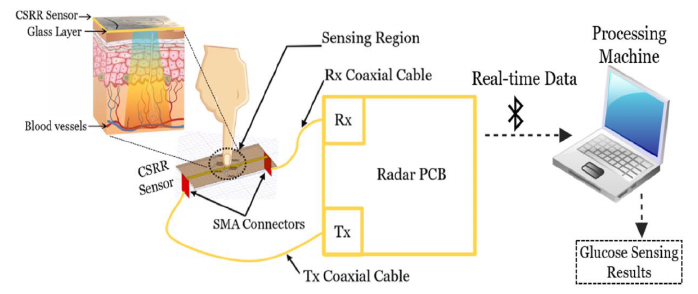
Figure 9. Working principle of the proposed sensor system by Omer et al. The portable radar-driven sensor measures the BGL by sensing electromagnetic waves of small wavelengths into the blood vessels of the fingertip (Reprinted from Ref.